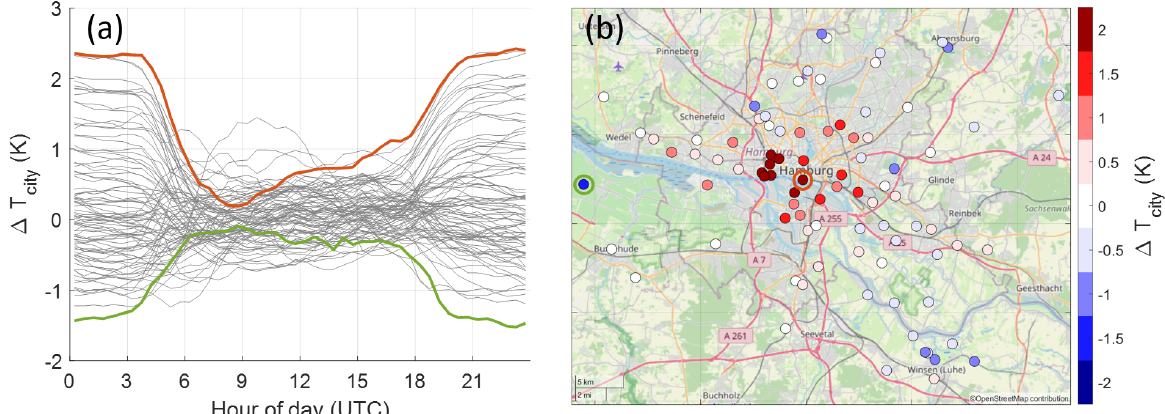
Figure 11. (a) Mean diurnal cycle of urban temperature modification (cid:49)T city and (b) nighttime (21:00 to 03:00UTC) mean of (cid:49)T city at all APOLLO and WXT stations from 15 June to 31 August 2020. Highlighted in orange and green are the urban station Wetterstation HafenCity (010WSa) and the rural station Obsthof Schuback (055OGw), respectively. © OpenStreetMap contributors 2021. Distributed under the Open Data Commons Open Database License (ODbL) v1.0.